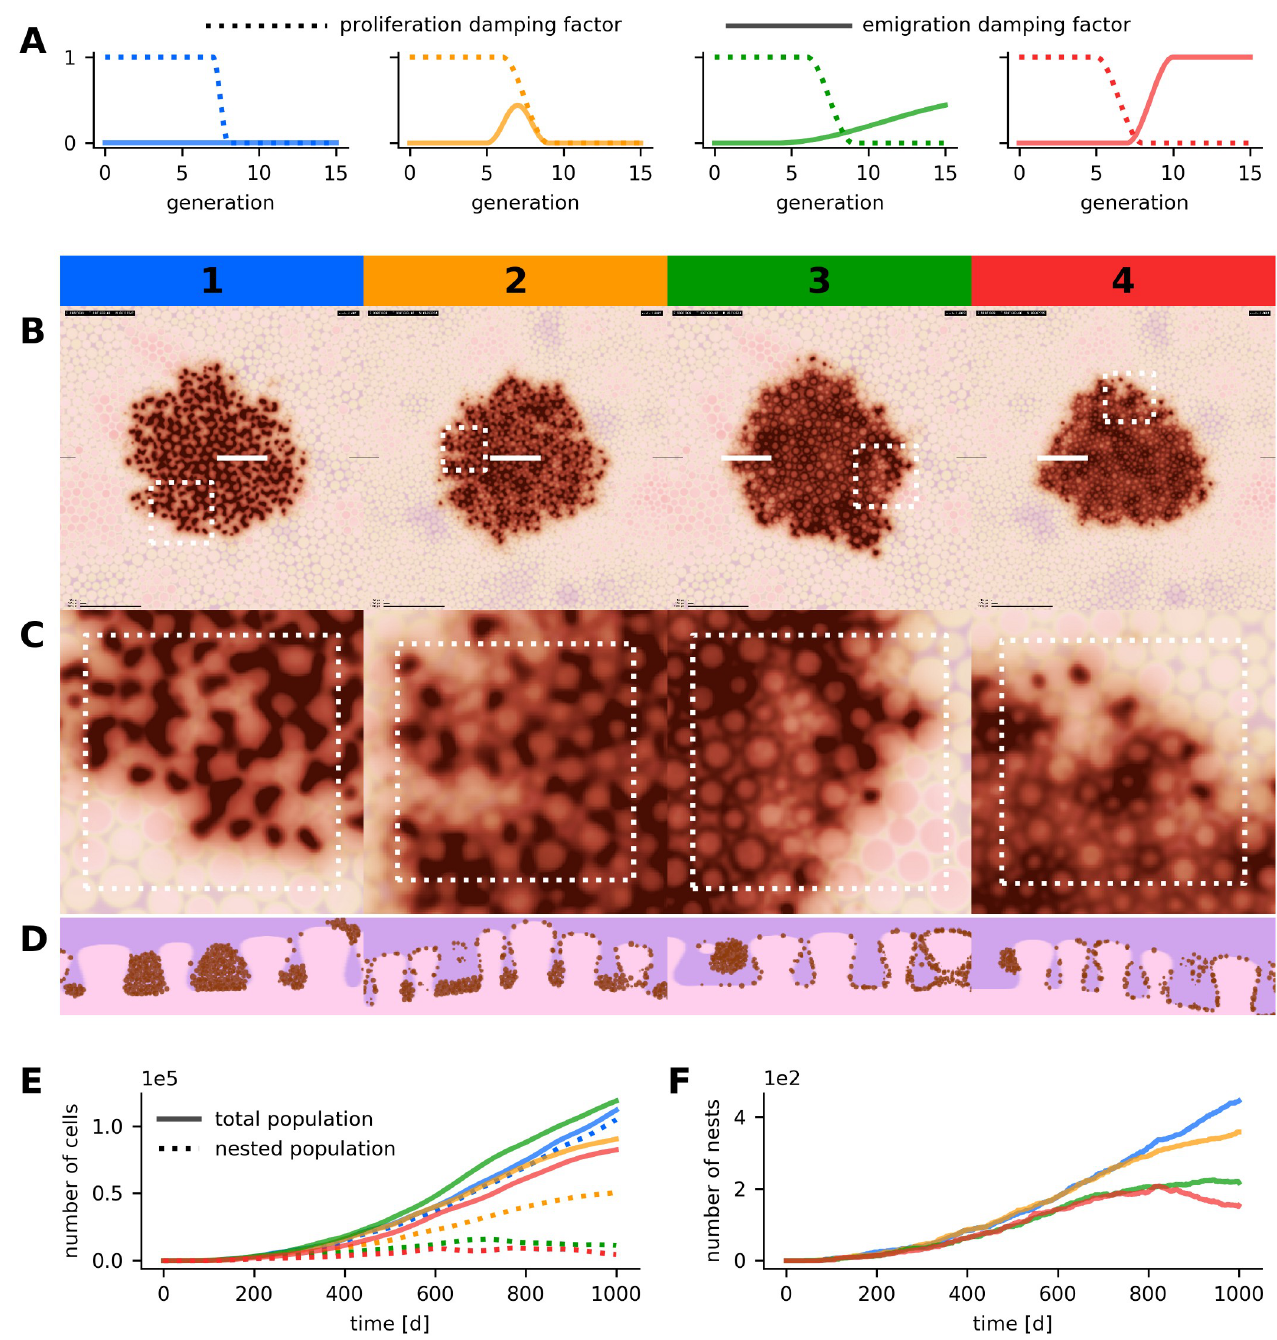
Fig 5. Parameter variation in simulated nevi with the globular pattern. Results of four simulation runs with different parameter configurations are compared. Numbering and color coding is analogous to Fig 4. (A) Configuration of the emigration and proliferation factors for each parameter scenario. (B, C, D) Dermatoscopic visualization of the cell population (B) with enlarged region (C) and histologic views (D). All images depict the state of the simulated lesions after 1,000 days, horizontal images display a region of 5,000 μ m × 5,000 μ m and white markers indicate the position of the enlarged region and of the histologic section. (E) Temporal evolution of the total and nested population size. (F) Temporal evolution of the number of globules. Simulated dermal tissue with larger papillae was used in scenarios 1 and 3. A detailed overview on the parameterization is available in Table C in S2 Text.